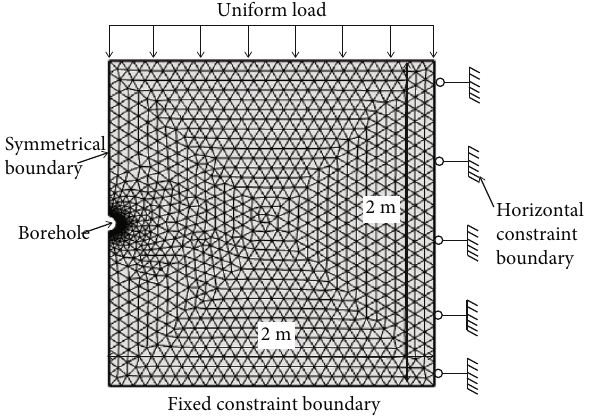
Figure 2: Geometric model.